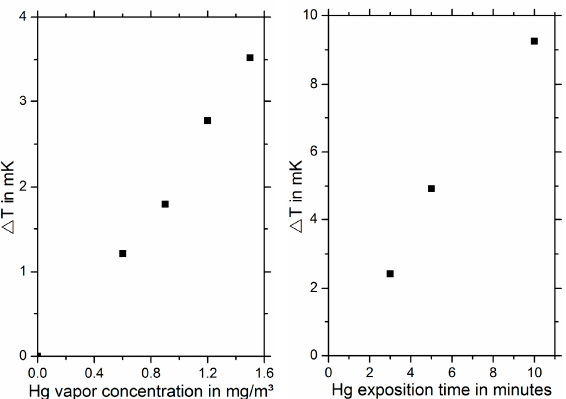
Figure 6. ( Left ) Δ T after 10 min of exposition to different Hg concentrations. The heating temperature is set to 70 °C. ( Right ) Δ T after exposition to 1.5 mg/m 3 Hg for three different exposition times. The heating temperature is set to 133